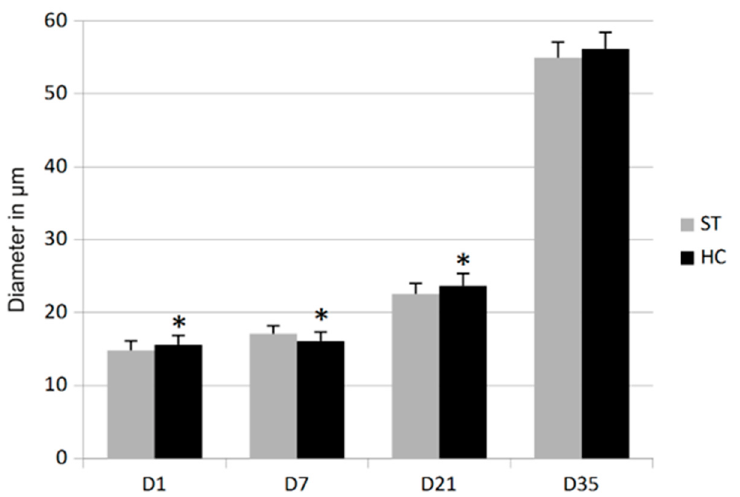
Figure 1. Diameter of the Pectoralis major muscle fibers in standard (ST) and HatchCare (HC) groups. * Significant difference compared to ST assessed in the t test (D1 t-value − 2.1086 p = 0.0404; D7 t-value 2.8754 p = 0.0063; and D21 t-value − 2.4406 p = 0.0186).